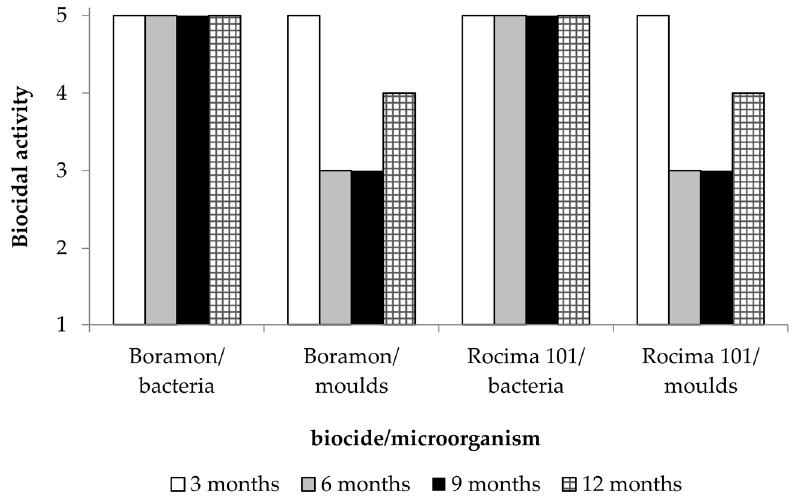
Figure 3. Effectiveness of biocides (Boramon at 30%, Rocima 101 at 8%) applied by spraying.